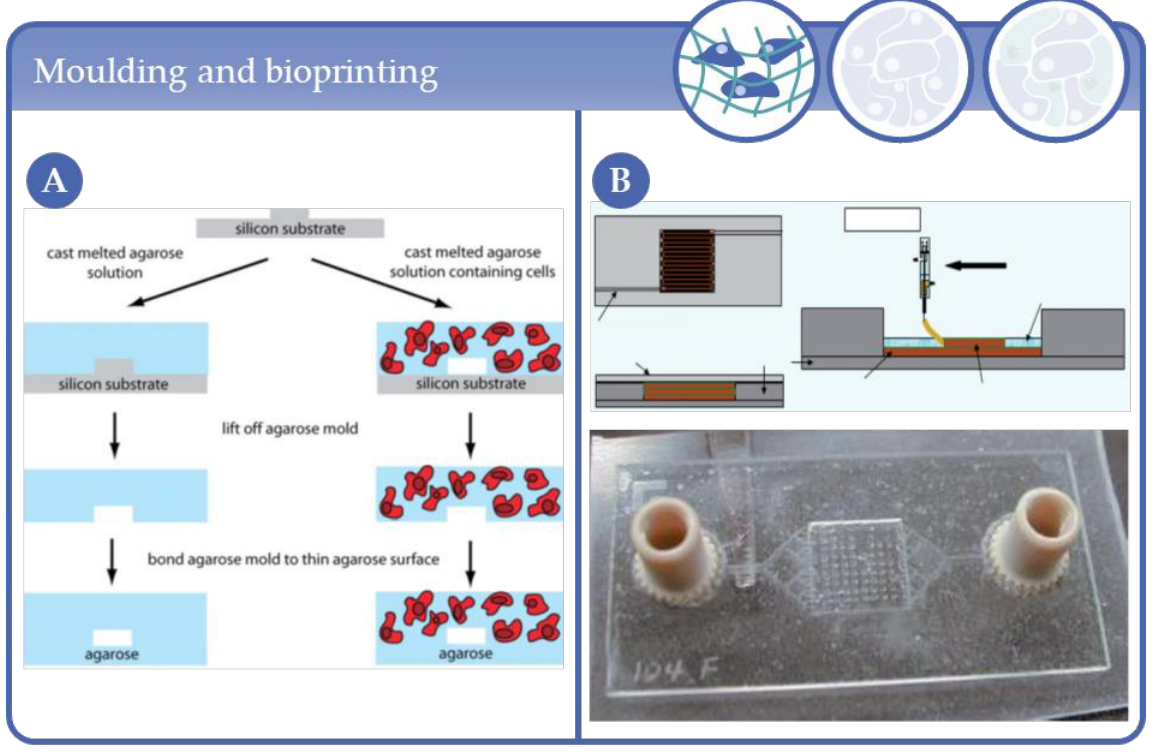
Figure 5. Microfluidic MBRs with microchannels fabricated by: ( A ) molding of cell laden agarose gels into patterned silicon wafers; reprinted from Ling et al. [20] with permission of the Royal Society of Chemistry, permission conveyed through Copyright Clearance Center, Inc. or ( B ) bioprinting of alginate encapsulated cells into glass etched channels; reprinted from Chang et al. [21] with permission from Springer Nature.